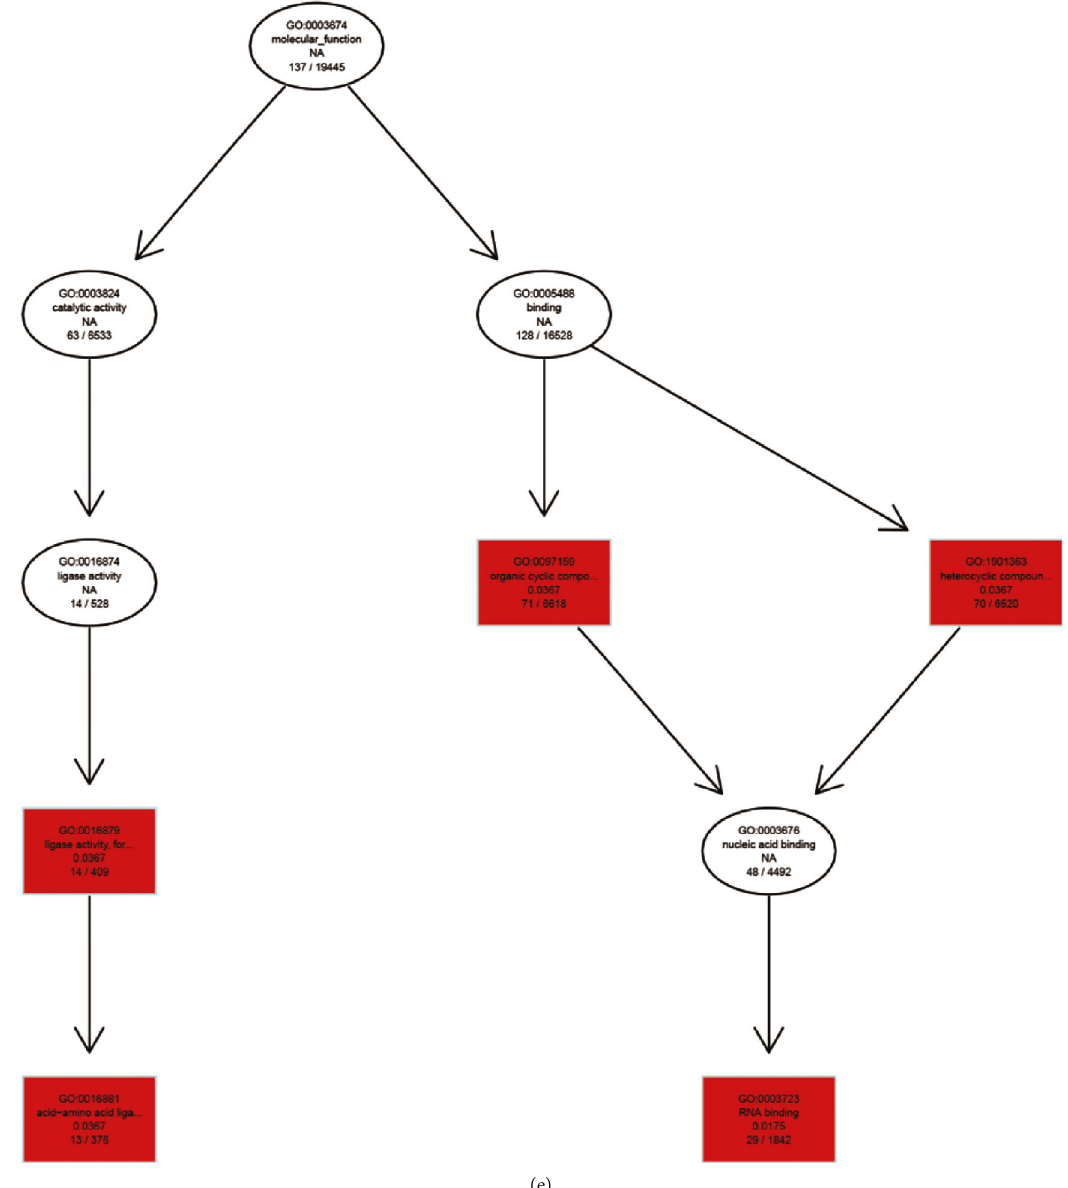
Figure 3: Enrichment analyses of all di ff erentially expressed circRNAs. (a) Biological process (BP), cell component (CC), and molecular factor (MF) of GO terms. (b) – (d) Directed acyclic graph (DAG) of BP, CC, and MF. (e) Top 20 KEGG pathways of host genes of all circular